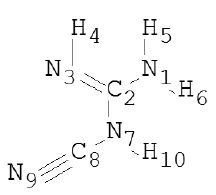
Figure 1. Structure of DCD.